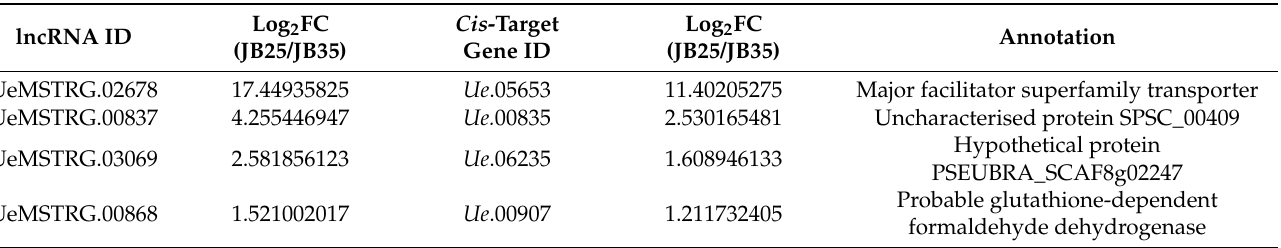
Table 1. Potential cis -target genes of differentially expressed lncRNAs in Ustilago esculenta between Zizania latifolia plants infected with U. esculenta grown at 25 ◦ C (JB25) and 35 ◦ C (JB35) † .